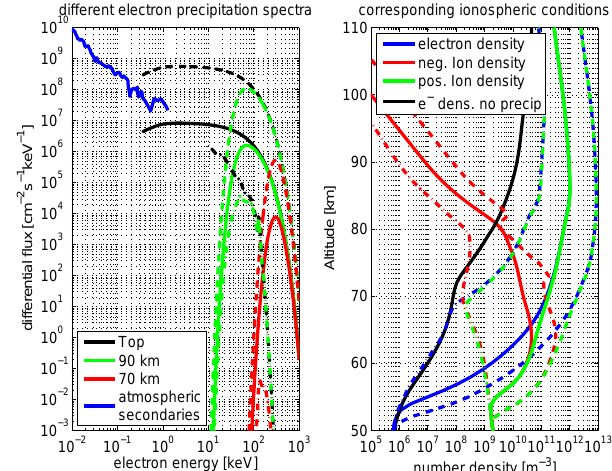
Figure 3. (Left) Electron precipitation spectra for weak (dash- dotted, data published in Miyoshi et al., 2015), medium (solid) and strong (dashed) conditions; spectra at the top of the atmosphere (black) and remnants at 90km (green) and 70km (red); and atmo- spheric secondary electron spectrum measured at 105km by Doer- ing (data taken from Fig. 4. of Pfister, 1967). (Right) corresponding to the precipitation cases the electron density (blue), negative ion density (red) and positive ion density (green) have been modeled using the SIC model together with the electron density (black) for a model run without electron